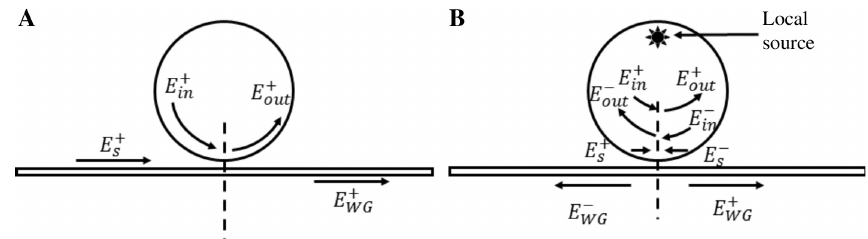
Figure 1: (A) [resp. (B)] Schematic view of a bus-waveguide excited TWR (resp. locally activated TWR). Situation (A) corresponds to the classical bus-waveguide excitation of the resonator. The incoming field is evanescently coupled to the resonator and back to the output waveguide. In situation (B), the light source is implanted within the resonator. The local source excites contra-directional traveling modes of the resonator that couple back into the output